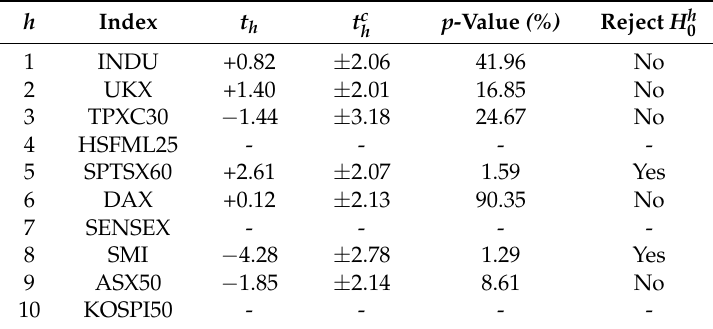
Table 8. Geographical stability test (95%) for γ ◦ :